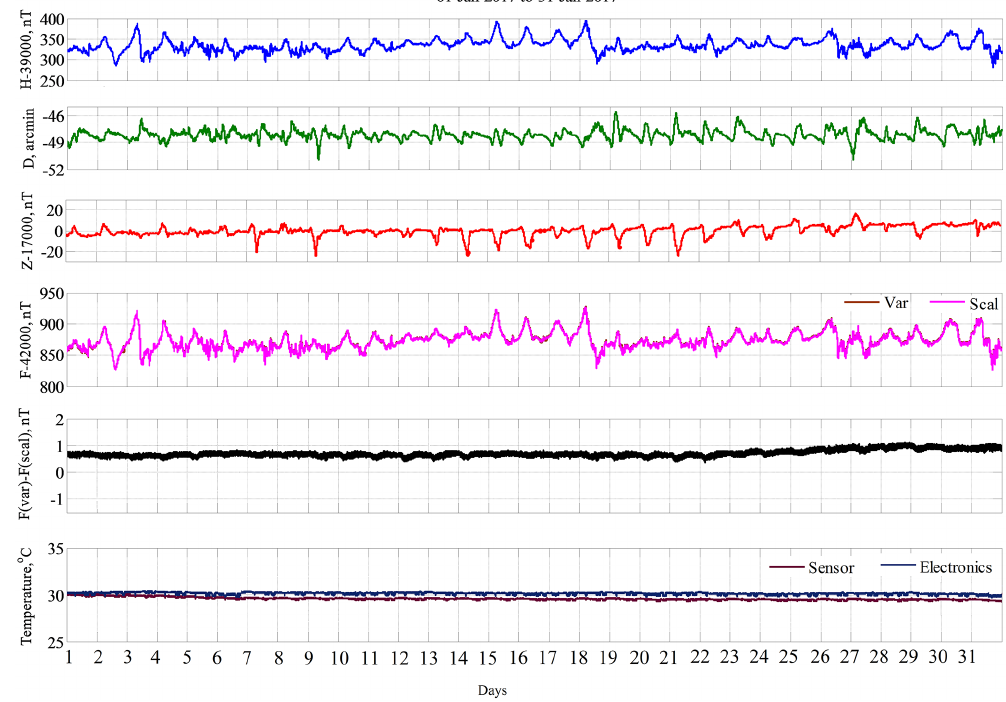
Figure 11. Example of 1 entire month, January 2017, of magnetic field measurements and sensor–electronics temperatures.